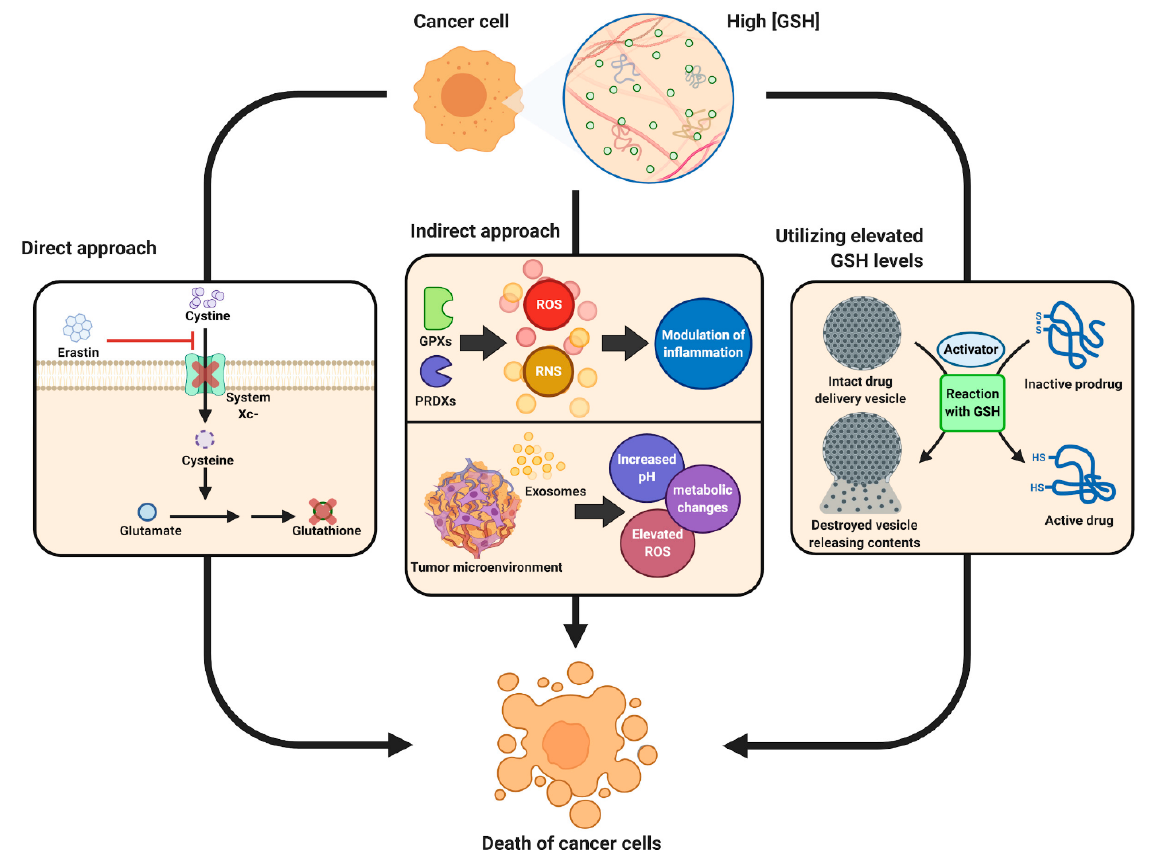
Figure 4. Schematic showing therapeutic role of glutathione in cancer tumor biology. Reproduced with permission from [15].